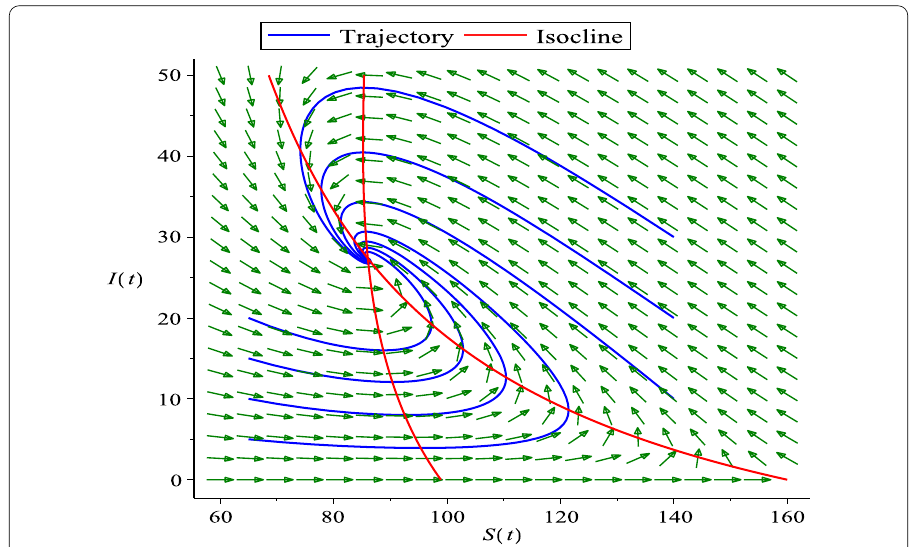
Figure 1 The vector field plot of model (2.5) without pulse effects. The equilibrium point E ∗ ( S ∗ , I ∗ ) is a stable